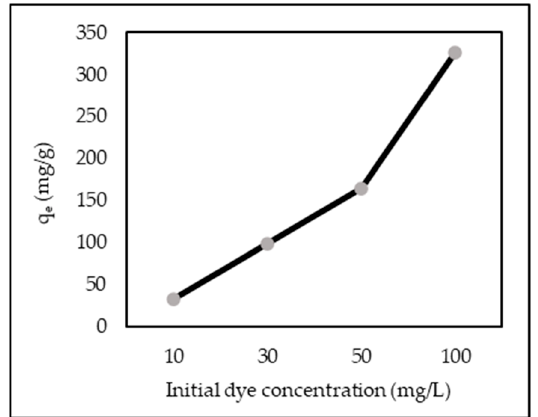
Figure 5. Effect of initial AR88 concentrations (ZL–CH hydrogel 30 mg, volume 100 mL, pH 2.0, contact time 15 min).